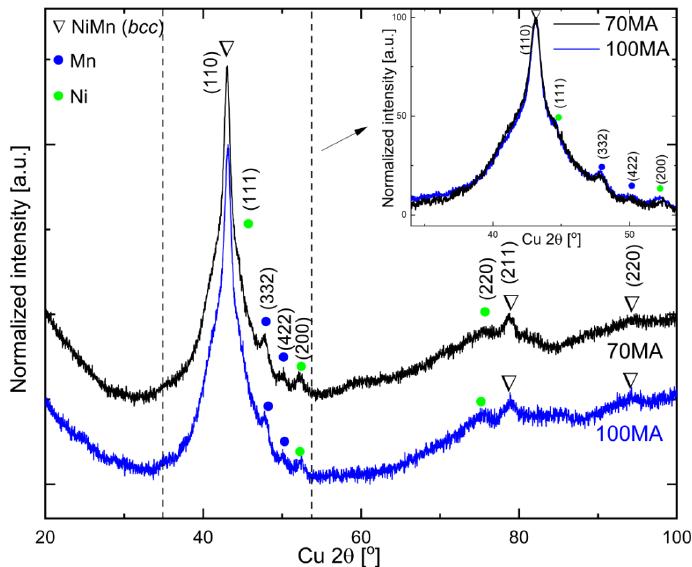
Figure 1. XRD patterns of as-milled powders produced by mechanical alloying for 70 h (70MA) and 100 h (100MA). Inset—superimposed XRD patters restricted to the region between dotted lines.